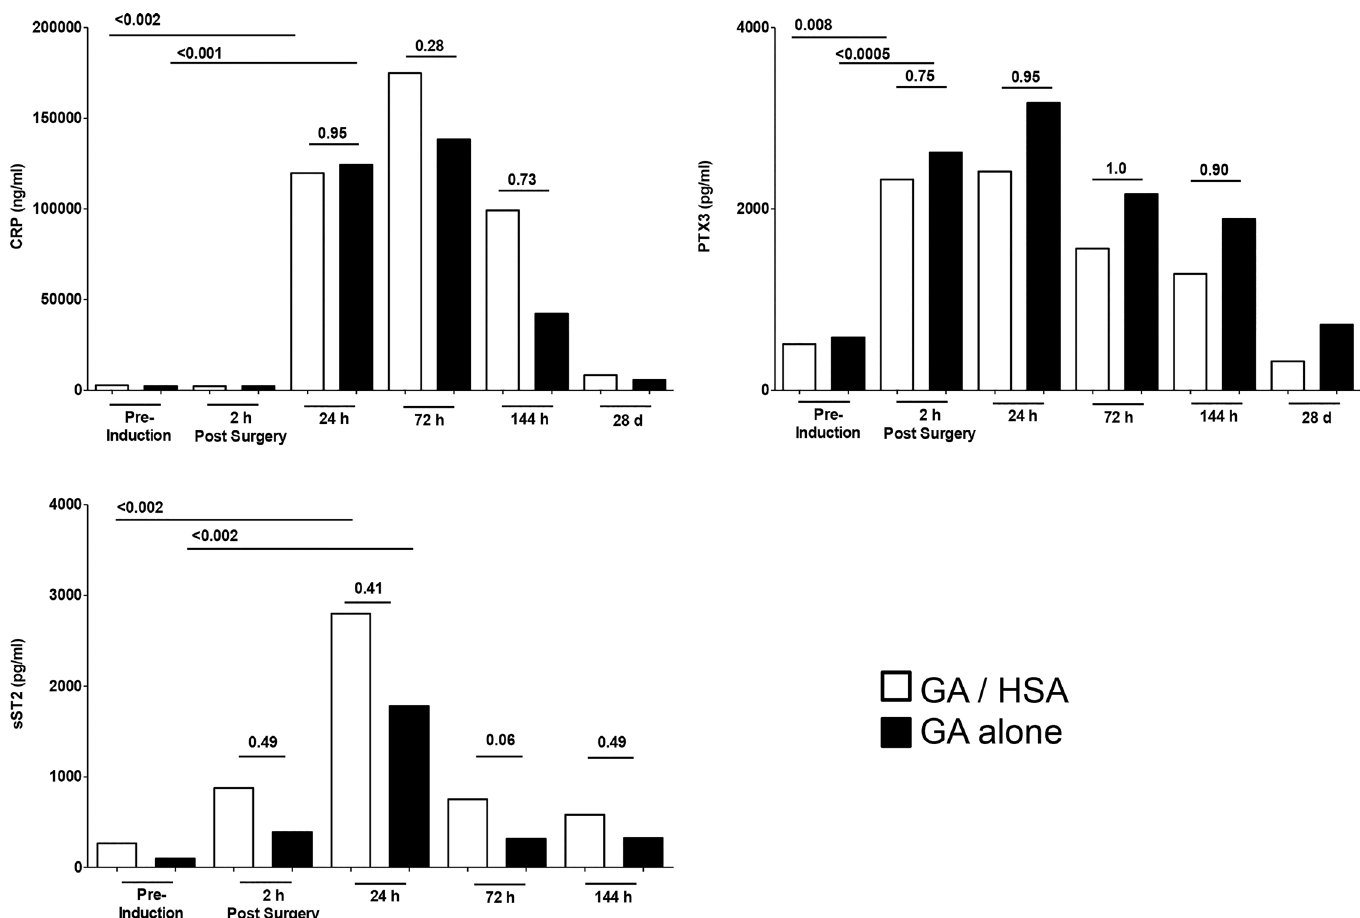
Fig 5. Acute phase protein responses in CABG patients receiving HSA/GA vs general anesthetic alone. Individuals received HSA plus general anesthetic (open) or general anesthetic alone (solid). P values reflect statistical significance (Mann